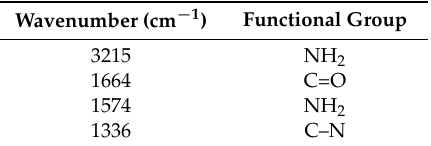
Table 2. Functional groups of chitosan.